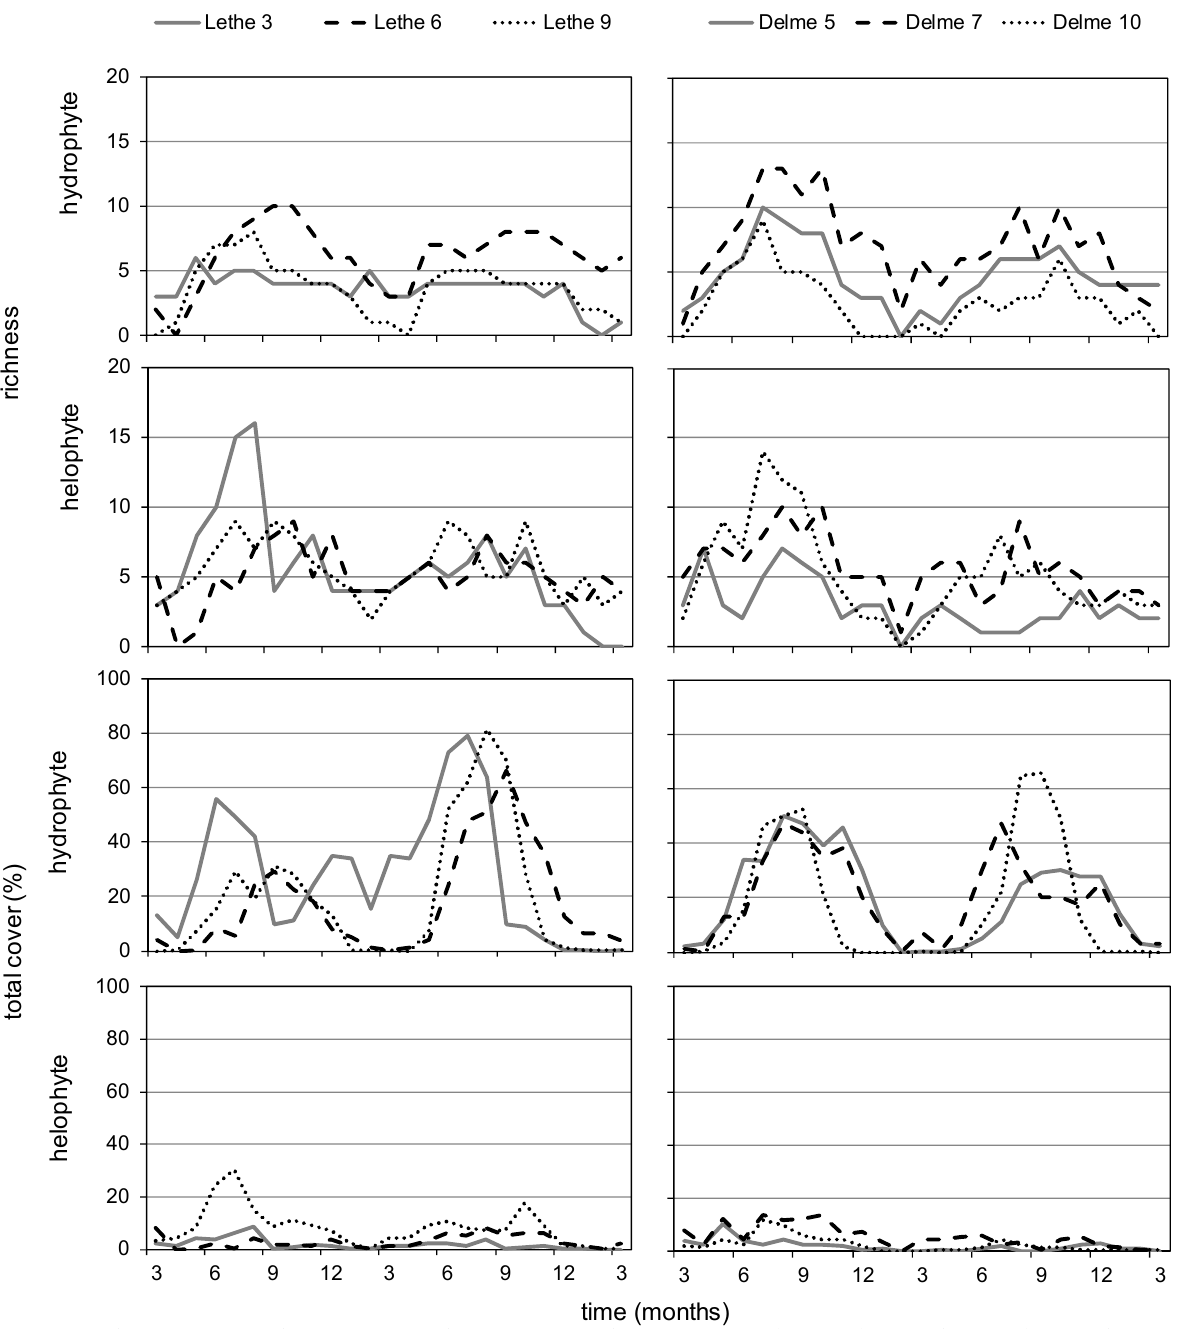
Figure 3. Monthly changes (March 1979 to March 1981) in richness and total cover (%) in hydrophyte and helophytes at six sites from the rivers Lethe and Delme (Lower Saxony,